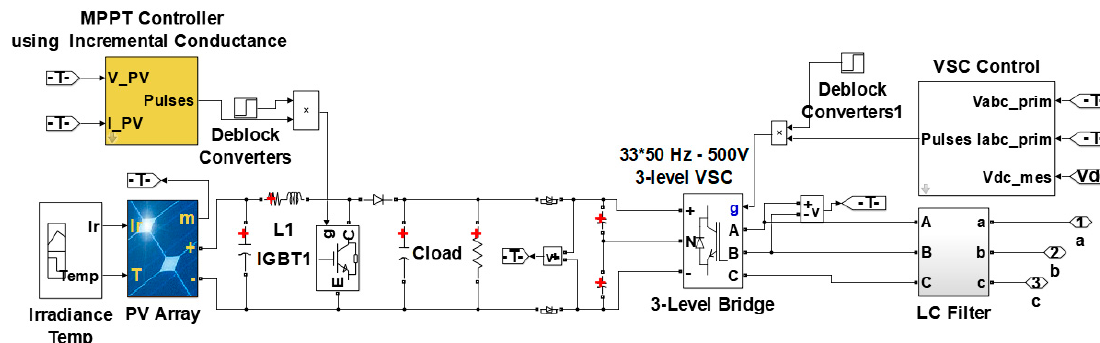
Figure 6. Simulink model of the Diesel Generator. 4. Selection of the Communication Medium The communication infrastructure for advanced DSM implementation needs two different types of communication. These communications exchange data information flow between the utility control center and the participating end-users [41]. Type-1 is the communications among the sensors, devices, and the domestic appliances to the smart meter or the smart gateway, which is the main brain of the whole system that collects necessary data from the connected sensors and sends it to the utility control center. Type-2 is the communication platform between the users’ smart meters and the utility center, which can be further divided into two types: point-to-point, and mesh networks [17]. The point-to-point communication platform is more like an open access network. It communicates with smart meters by authorized entities, using a third party telecommunication network through